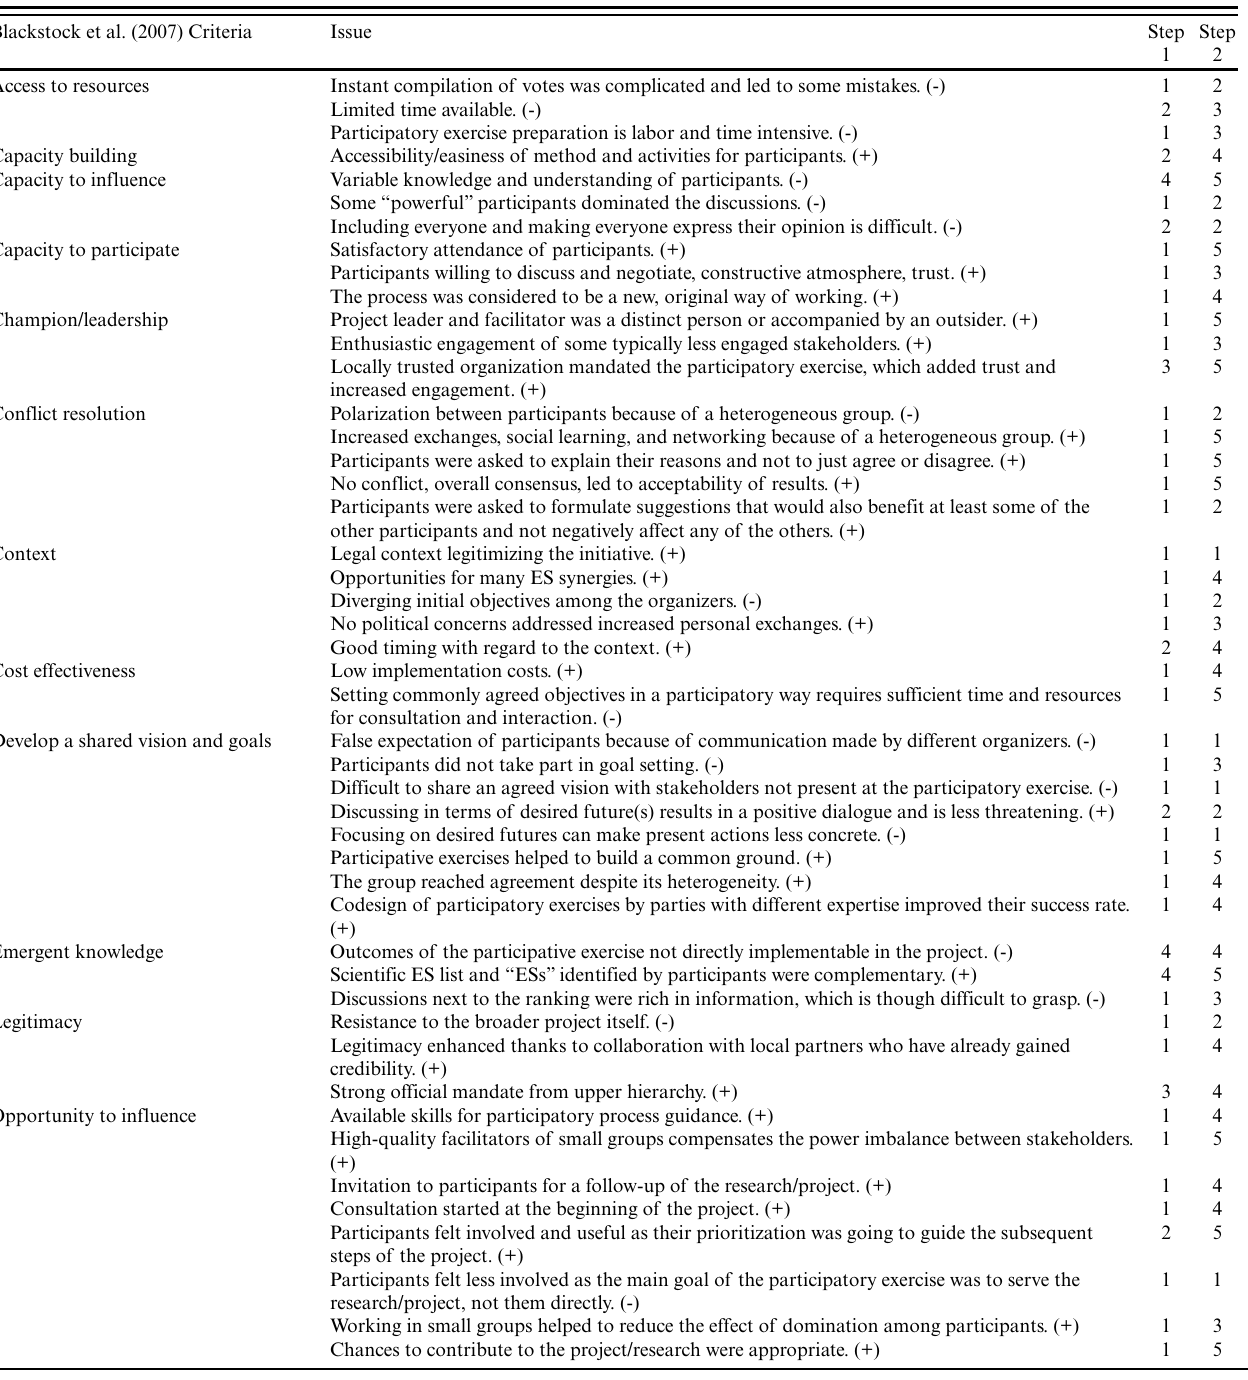
Table 3 . Issues raised at the self-evaluation workshop among case study (CS) researchers (column 2) and mapped onto the Blackstock et al. (2007) criteria (column 1). The symbol in brackets indicates whether the issue refers to a success (+) or a barrier (-). Column 3 indicates how many CS researchers spontaneously considered that issue. Column 4 shows to how many CS researchers the issue applies, i.e., the number of CSs that shared the same issue (maximum =